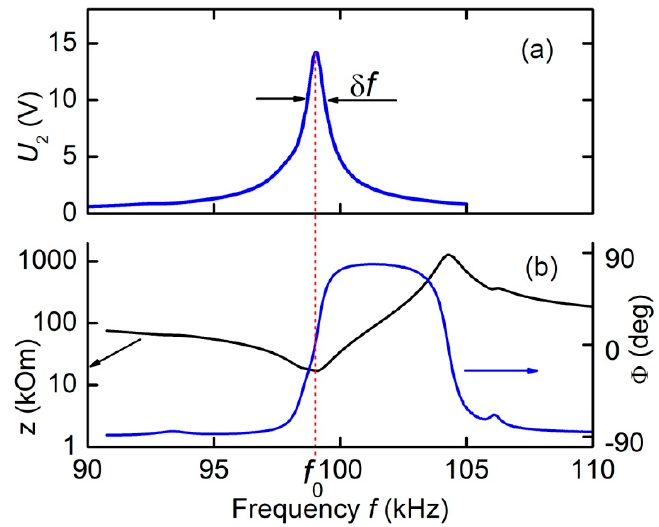
Figure 2. Dependences of the output voltage U 2 ( a ) as well as the magnitude Z and the phase Ф ( b ) of the output impedance of the magnetoelectric (ME) transformer on the voltage frequency f . Measurements were carried out under open-circuit condition.